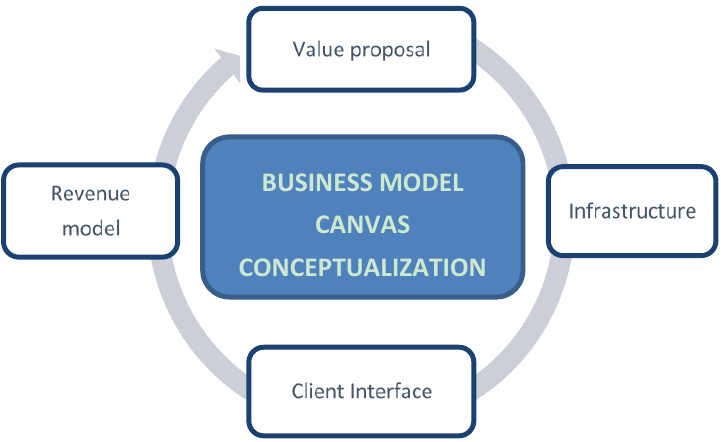
Figure 5. Conceptualization of business model